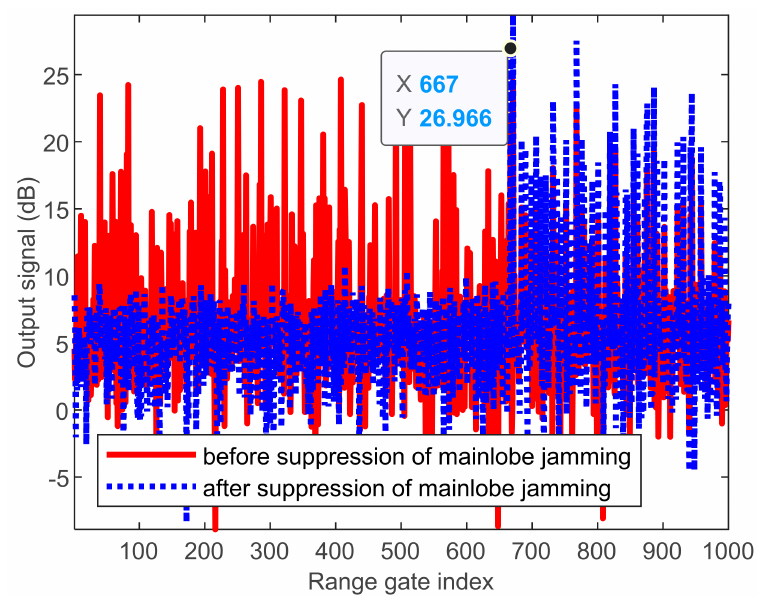
Figure 6. Fourier power spectra of output signal in normalized Doppler frequency and range dimensions. ( a ) Receive beamforming. ( b ) Transmit beamforming.